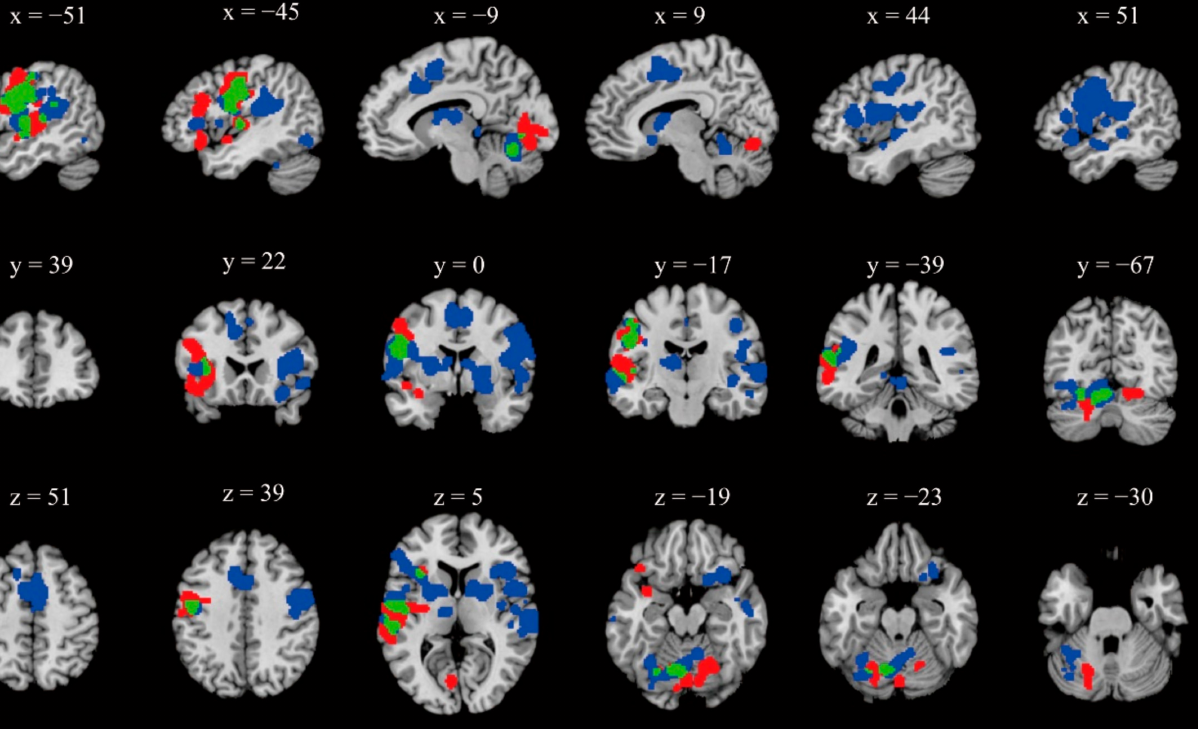
Figure 2. Activation likelihood maps for analyses of PWNS group (red), PWS group (blue) and their overlap (green) (uncorrected p <